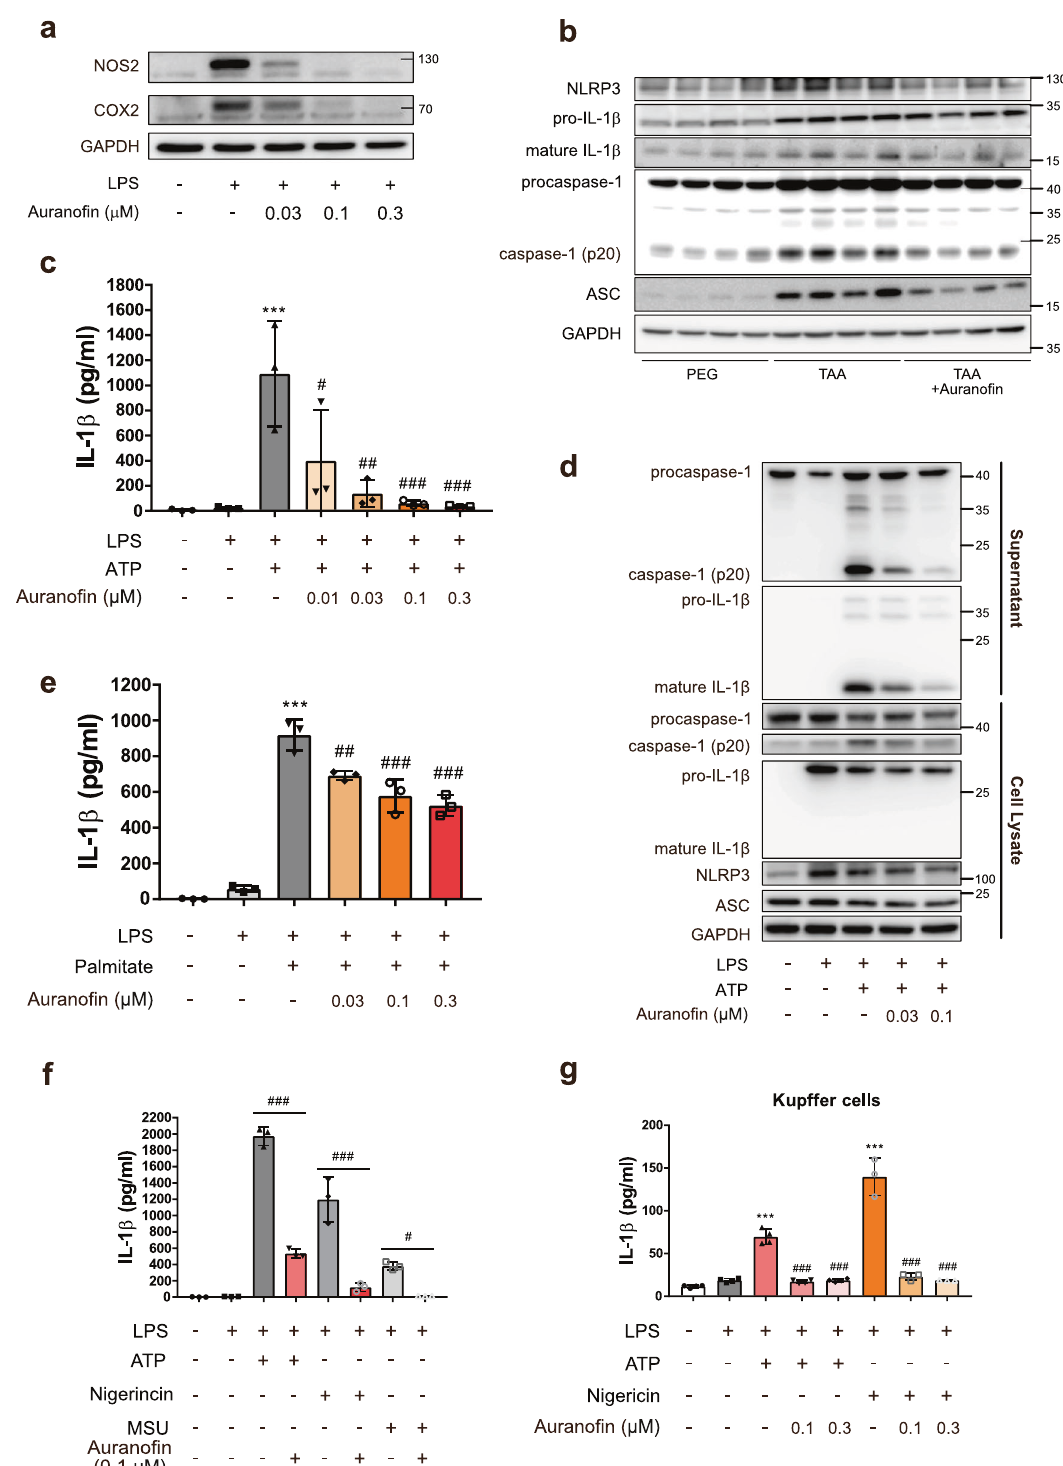
Fig. 2 Aurano fi n inhibits NLRP3 in fl ammasome-mediated IL-1 β release. a Aurano fi n inhibited LPS induced in fl ammation in BMDM. b Western blot analysis of NLRP3, pro-IL-1 β , mature IL-1 β , procaspase-1 and ASC in liver lysates. c , d Effects of aurano fi n on ATP triggered IL-1 β release in LPS-primed bone marrow-derived macrophage (BMDM), n = 3. BMDMs were primed with LPS (100 ng/ml) for 4 h, followed by exposure to ATP (1 mM) and aurano fi n for 1 h. e Effect of aurano fi n on palmitate (400 µ M) triggered IL-1 β release in LPS-primed BMDM, n = 3. f Effects of aurano fi n on nigericin (2 µ M) or 200 µ g/ml monosodium urate (MSU) triggered IL-1 β release in LPS-primed BMDM, n = 3. h Effects of aurano fi n on ATP (1 mM) or nigericin (2 µ M) triggered IL-1 β release in kupffer cells, n = 3 or 4. Data are presented as mean ± SD ( c , e , f , and g ), analyzed by one-way ANOVA followed by Tuckey ’ s test; *** p < 0.001, compared to control; # p < 0.05, ## p < 0.01, and ### p < 0.001 compared to NLRP3 in fl ammasome-induced